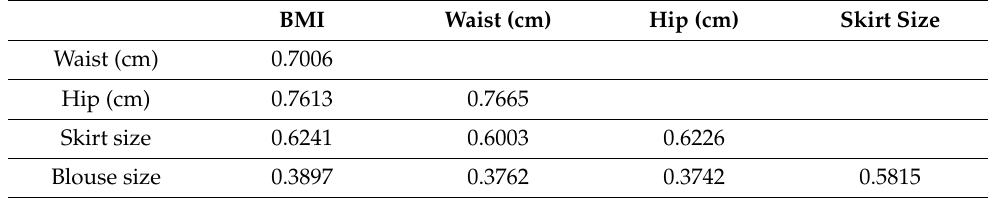
Table 2. Correlation between conventional adiposity indices and clothing sizes in the